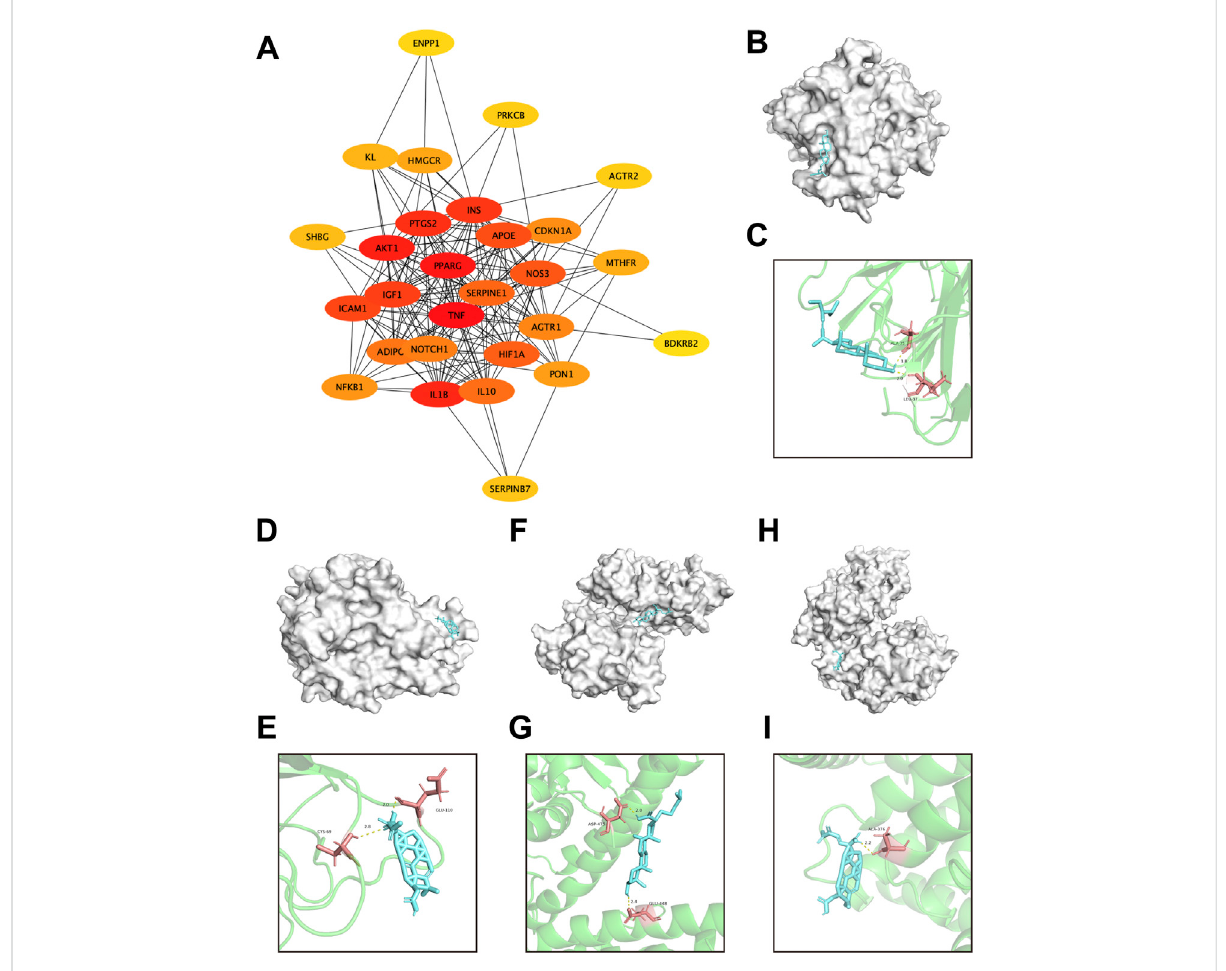
FIGURE 9 Screening of pivotal common targets and molecular docking of these targets binding to DSS ingredients. (A) Protein-protein interaction network of28commontargets,ranked byCutohubba tool.Theredderthecolor,themorelikelyitisto bepivotal targets. (B,C) Molecular dockingof stigmasterol with TNF. (D,E) Molecular docking of poricoic acid C with TNF. (F,G) Molecular docking of eburicoic acid with PPARG. (H,I) Molecular docking of poricoic acid C with PPARG. The blue small molecular structures represent the ingredients. And the white macromolecules represent screened important macromolecular receptors in panel (B,D,F,H) . The green structures in panel (C,E,G,I) represent screened macromolecular receptor structures, while the red sticks represent the interacted residuals, the yellow dotted line represent intermolecular hydrogen